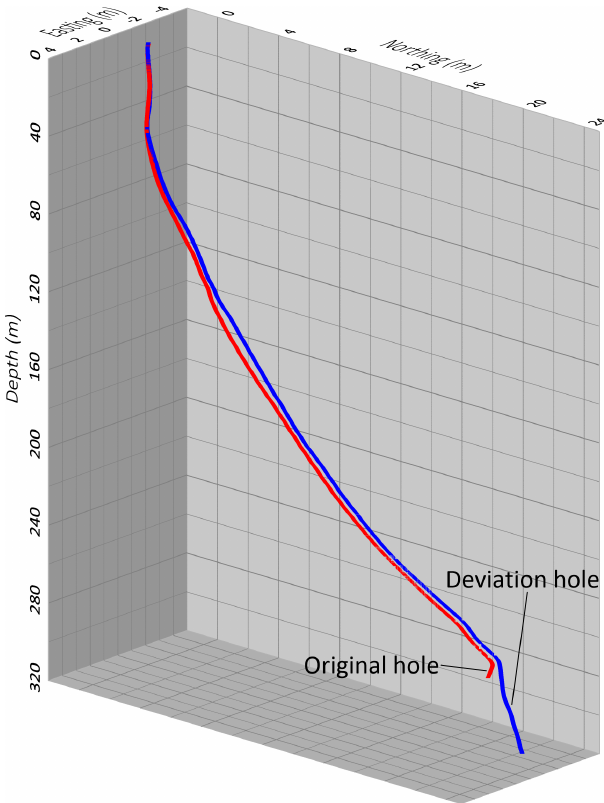
Figure 14. The 3-D orientation of the Little Dome C 2021/22 bore- holes. Down to a depth of 270m, where the records are from the same hole, the difference between the red and blue curve indicates the uncertainty in the determination of the position based on the logger data.